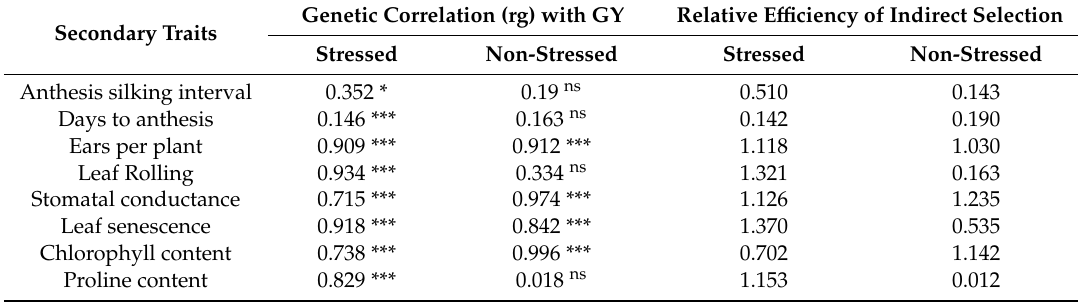
Table 5. Genetic correlations and the relative e ffi ciency of indirect selection through secondary traits for grain yield improvement under drought stress and optimum